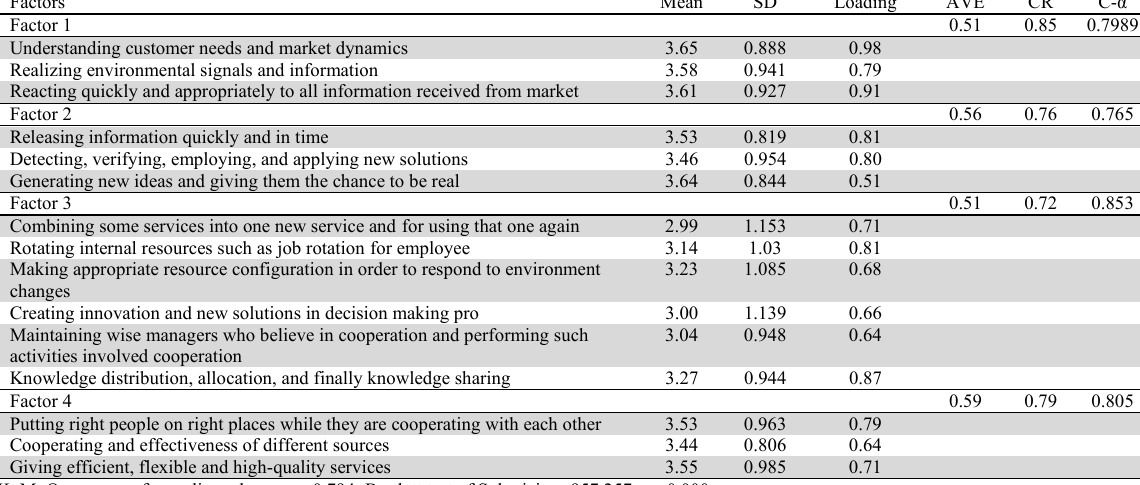
Results of CFA and internal reliability testing & K–M–O